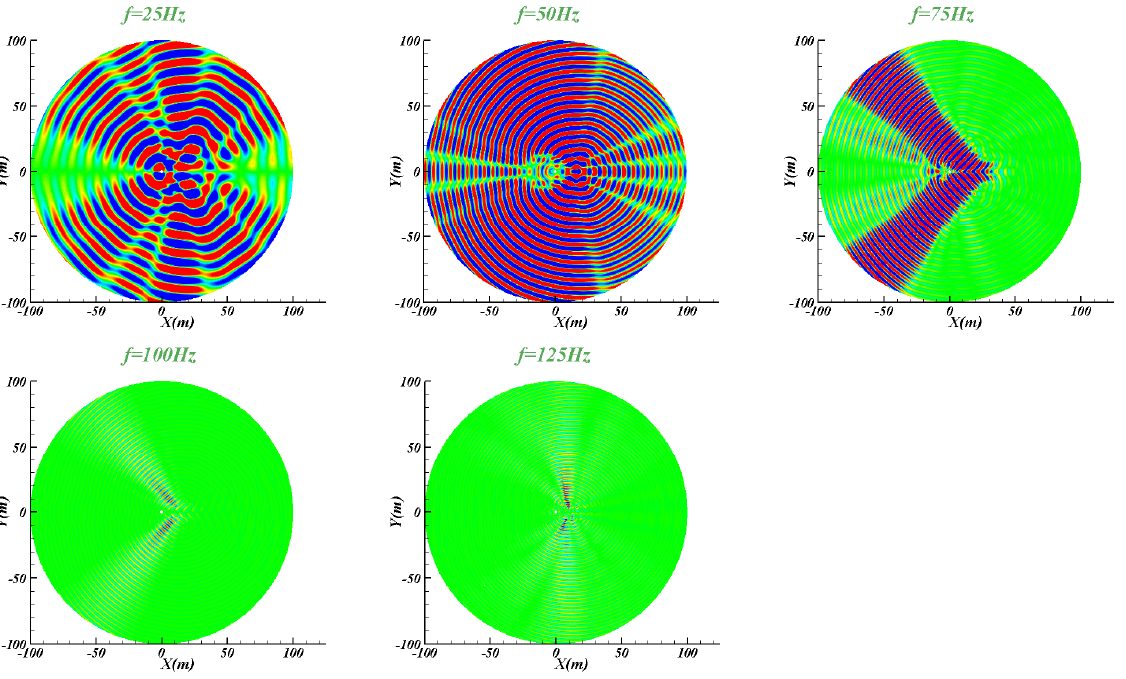
Figure 19. The sound field corresponding to different frequencies. Next, 36 monitoring points were arranged in the space to analyze the characteristics of the sound pressure level (SPL) spectral and the directivity of the overall SPL. The distance between the monitoring points and the rotating axis of the cylinder was 50 m, as shown in Figure 20. The overall sound pressure level (OASPL) curve is shown in Figure 21. This shows that the OASPL values of the four configurations were symmetrically distributed along the y = 0. For Case4, there were obvious low OASPL values near 0, 100, 180, and 260 degrees, and high OASPL values near 70 and 290 degrees. Similar to Case4, Case3 had low OASPL values at 100 and 260 degrees, and high OASPL values at 70 and 290 degrees. Unlike Case4, Case3 had no obvious low OASPL values in the 0~180 angle regions. Compared with Case4, the OASPL intensity distribution of Case1 and Case2 were more uniform. When one motion parameter in rotation amplitude or rotation frequency was constant, the difference of OASPL value was more obvious with the increase in the other